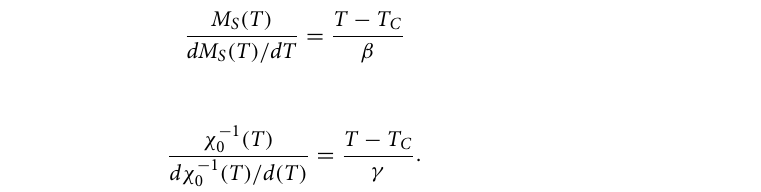
Fig. 7a. The solid lines in Fig. 7a represent fit to the M S and χ 0 using Eqs. (8) and (9), respectively. The KF method